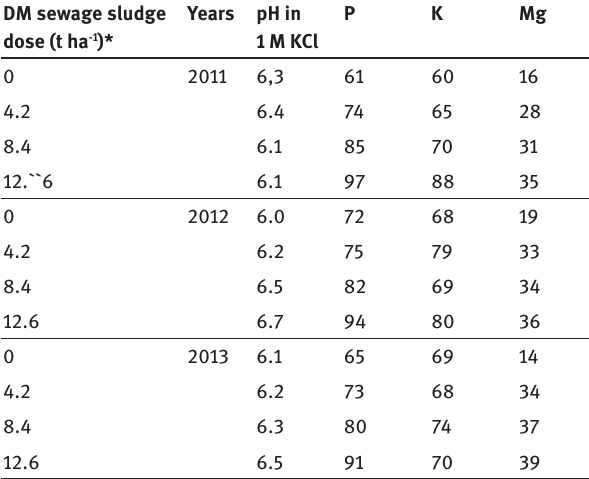
Table 3: Soil macroelements (mg kg -1 ) and pH.